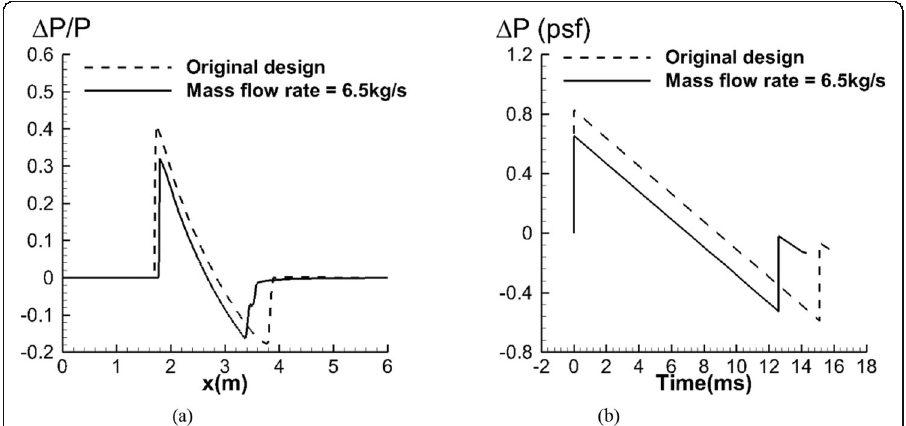
comparison of the ground boom signature